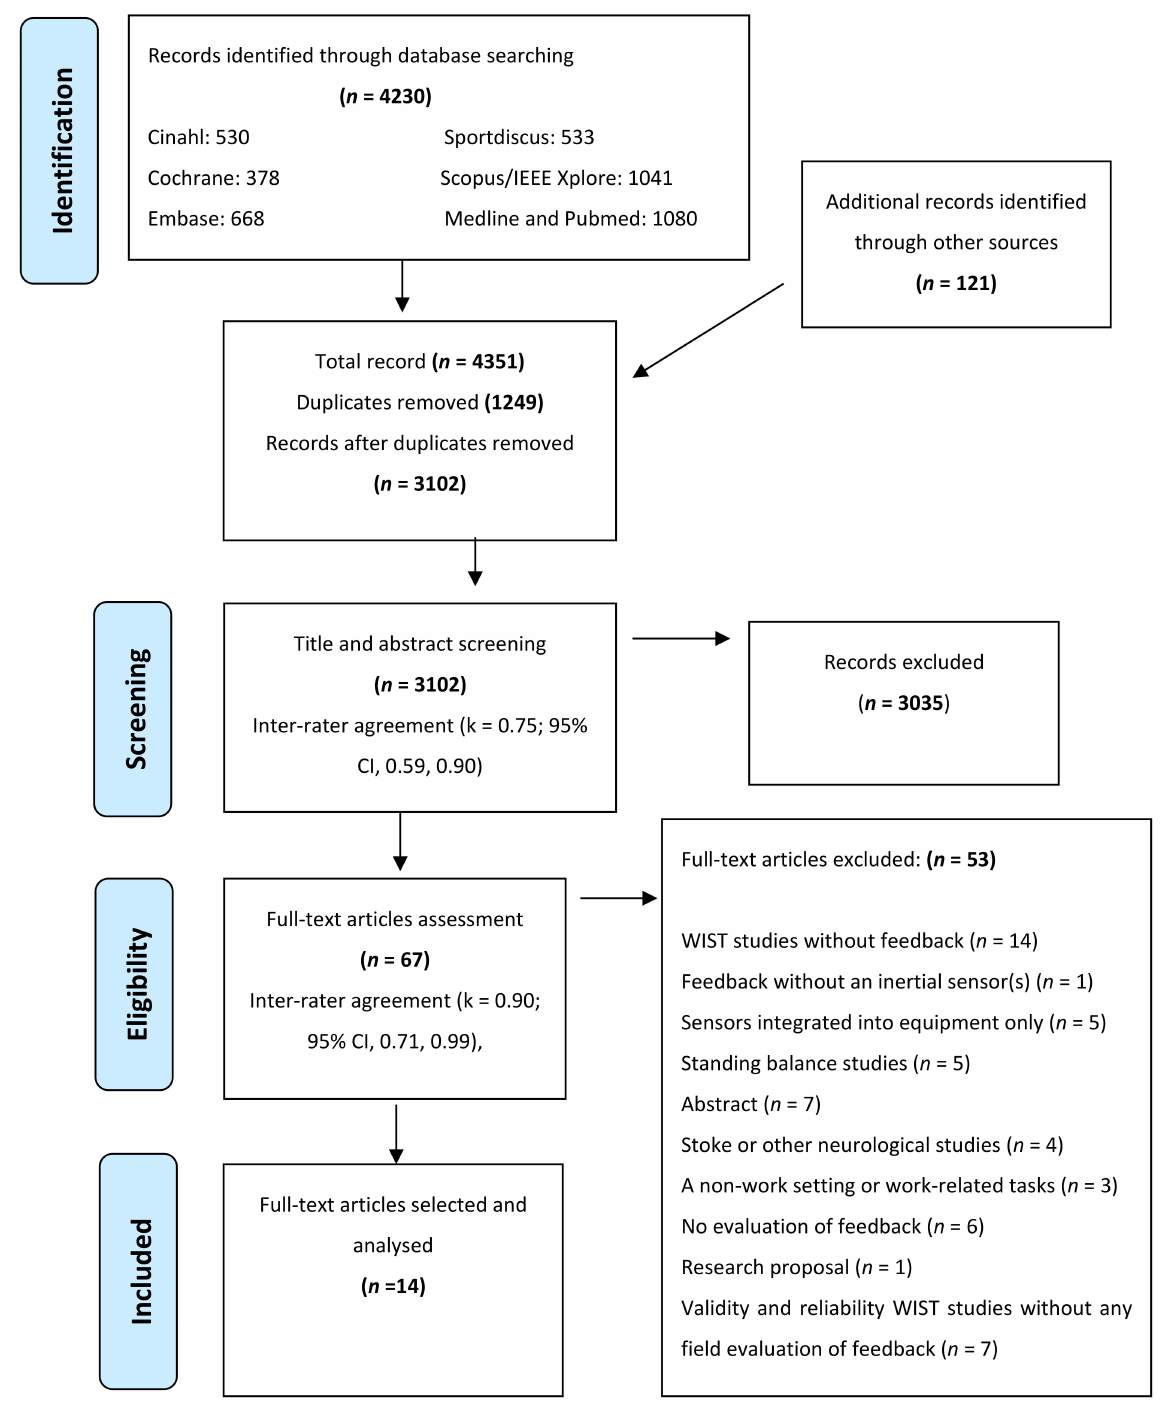
Figure 1. PRISMA diagram of the study selection